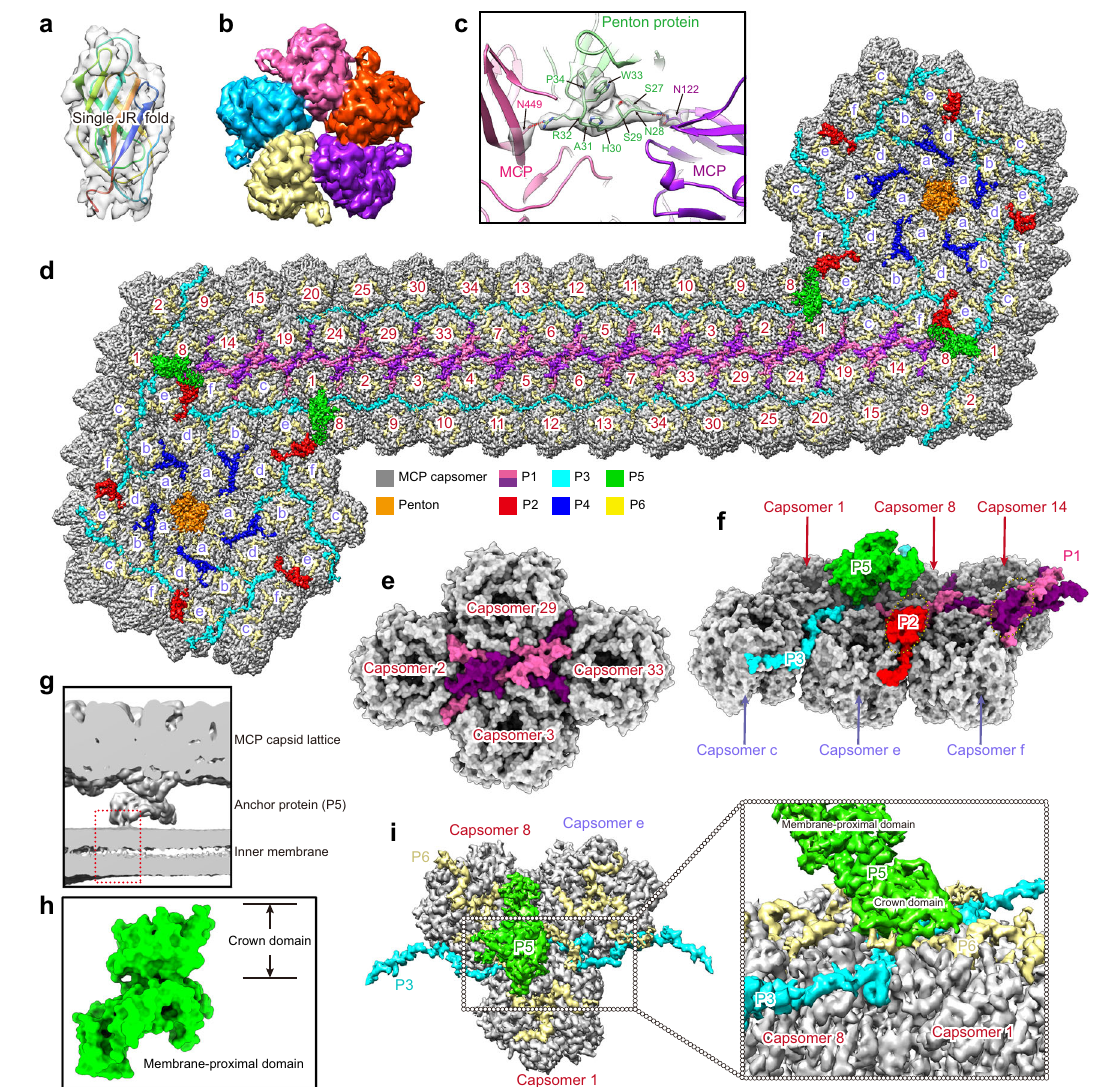
Fig.3|StructuresanddistributionsofmCPs.a Atomicmodelanddensitymapof onepenton(VP14)monomer.RainbowcoloringfrombluetoredindicatestheN-to C-terminus of the residues. b A pentamer formed by fi ve penton proteins in the fi vefold vertex. Five penton proteins are colored in khaki, purple, orange red, hot pink,and deep skyblue,respectively. c Each pentonproteincontacts twoadjacent MCPprotomers.The pentonprotein iscoloredgreen,and twoMCP protomersare colored hot pink and purple. The interface is viewed insidethe virion. H-bonds are labeled as red dashed lines, and corresponding residues are shown as sticks. The local density map with the model fi tted covering the above contact residues is shown as gray surfaces. d Overall arrangement of mCPs beneath the zipper region andpentasymmetron,whichisviewedinsidethevirions.Onezipperbandlinkstwo adjacent pentasymmetrons together. MCPs and mCPs are colored corresponding to Fig.1c,and the MCPcapsomersarenumbered asinFig. 1c. e The atomic models of one P1 (zip protein) dimer and its neighboring MCP capsomers. Two protomers